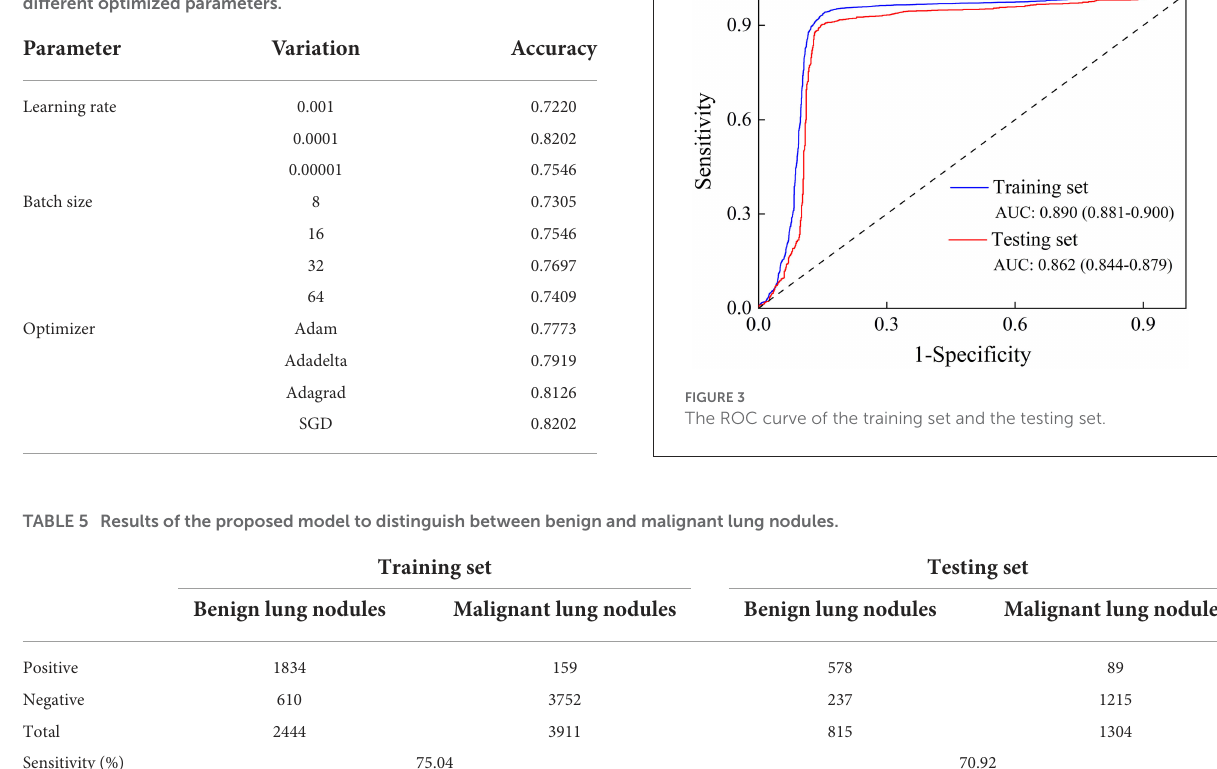
TABLE 4 Accuracy and loss value of the proposed method with different optimized parameters.